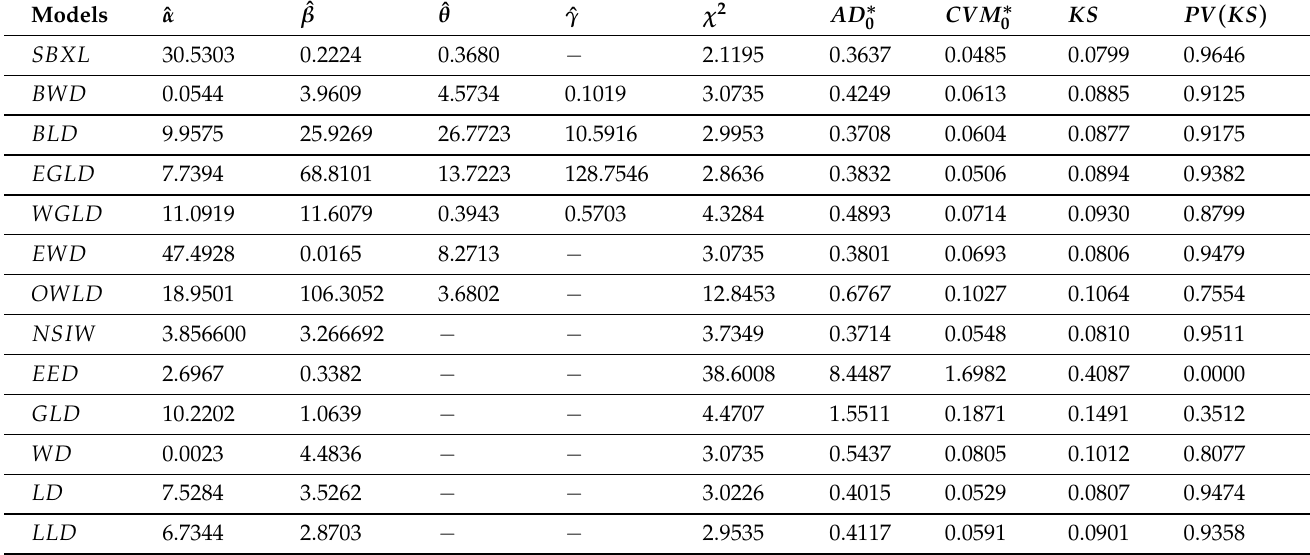
Table 7. MLEs and goodness-of-fit of data set-I.